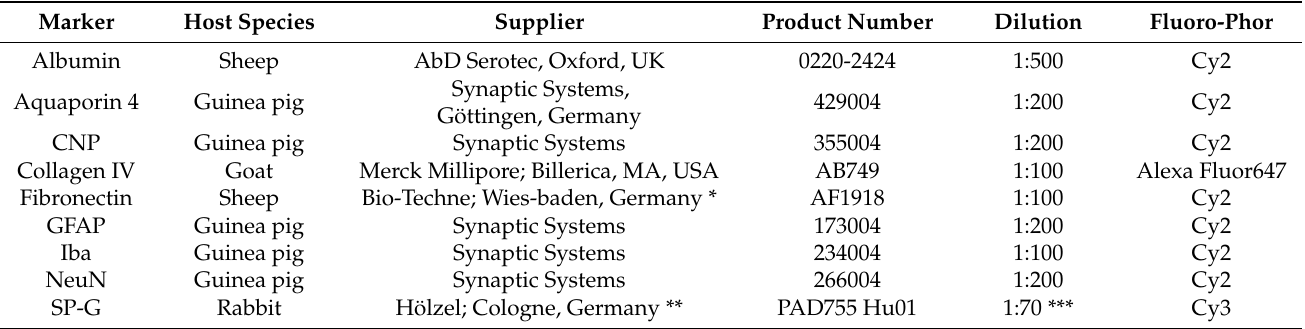
Table 1. Applied primary